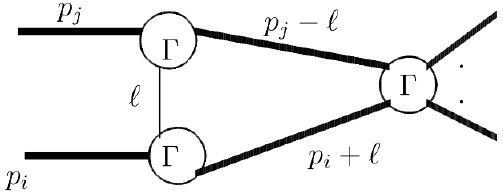
Figure 5 . Potentially infrared divergent contribution to the